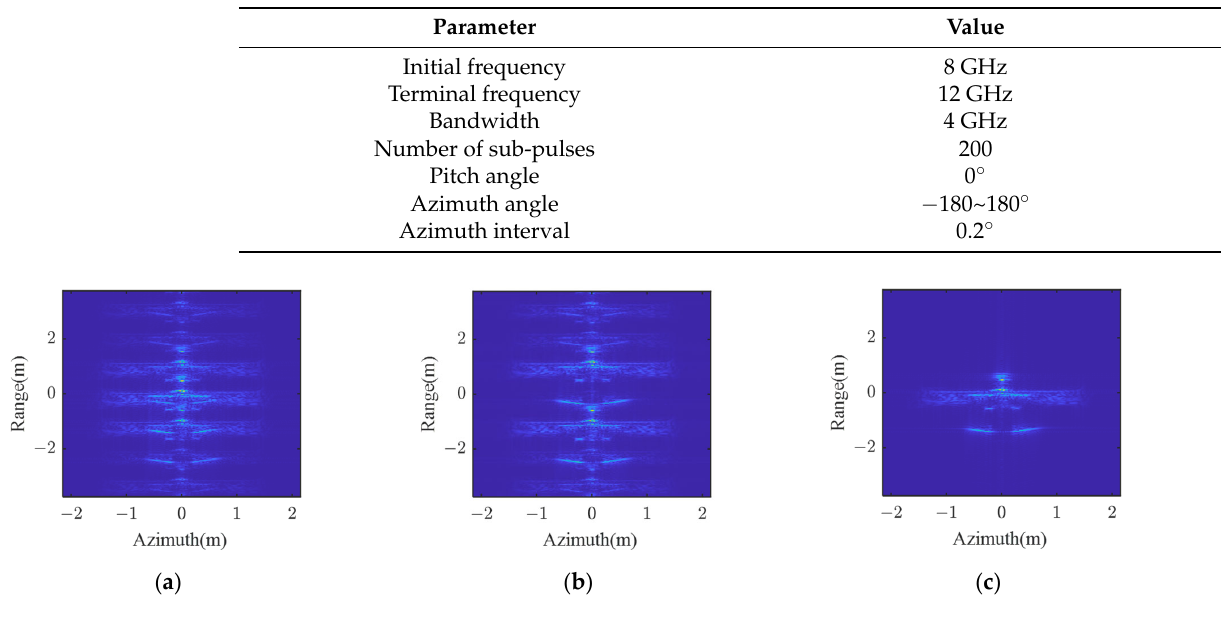
Figure 11. UAV imaging results in an anechoic chamber: ( a ) Imaging result of the first segment of the echo; ( b ) Imaging result of the combined echo; ( c ) Imaging result after cancellation.